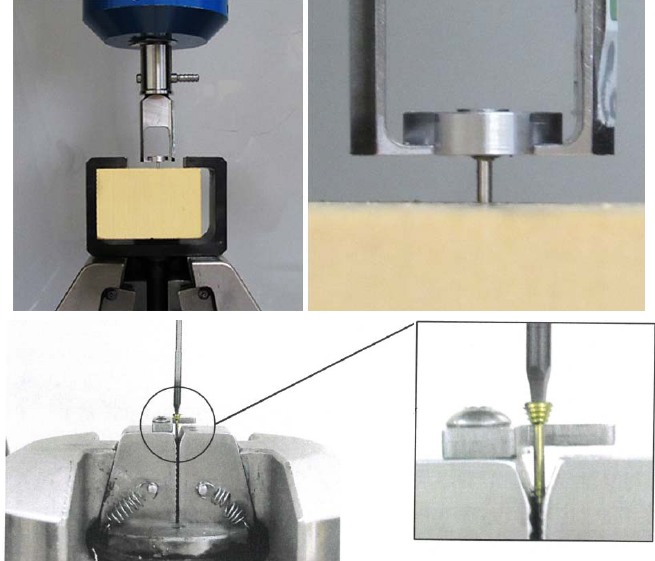
Figure 2. The MTS Insight 100 kN testing system with electromechanical drive system used for determining the axial pull-out strength (upper pictires) as well torsional properties (lower pictures) of medical bone screws.